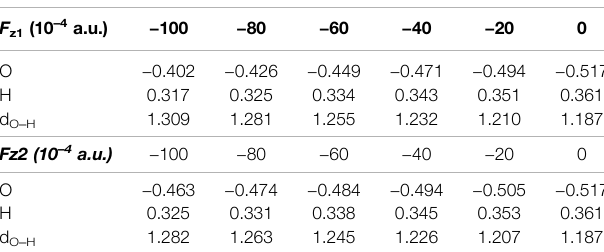
TABLE4| TheO ‒ HLengths(Å),theNPAcharges(|e|)oftheOandHatomsofthe TS1 under different electric fi eld